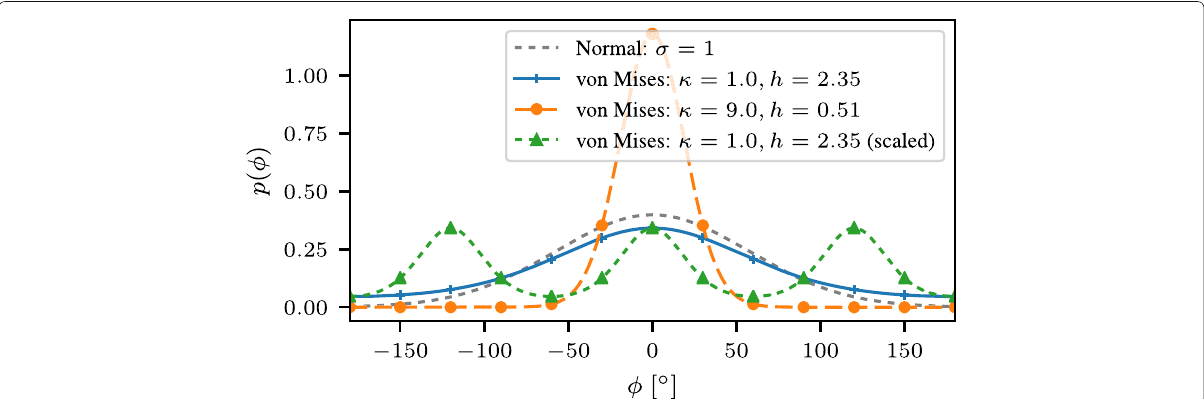
Fig. 10 PDFs for different von Mises distributions. The three times repeated version with κ = 1 (green) has the same lobe width as the von Mises distribution with κ = 9 (orange) but matches the entropy of the von Mises distribution with κ = 1